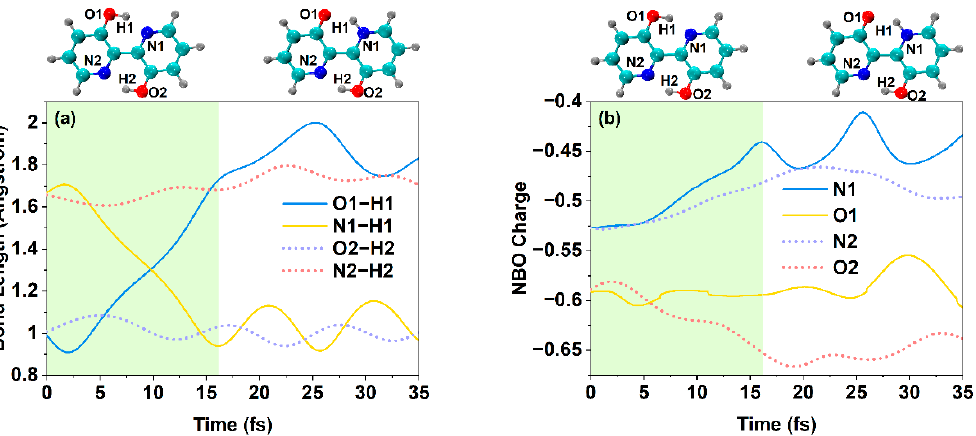
Figure 6. ( a ) The important bond lengths with time evolution, including the Enol* form (left) and Keto*1 form (right) and ( b ) the NBO charge of primary atoms with time evolution for BP(OH) 2 , including the Enol* form (left) and Keto*1 form (right). Atoms of different colors in the Enol* and Keto* are represented as in Figure 1.